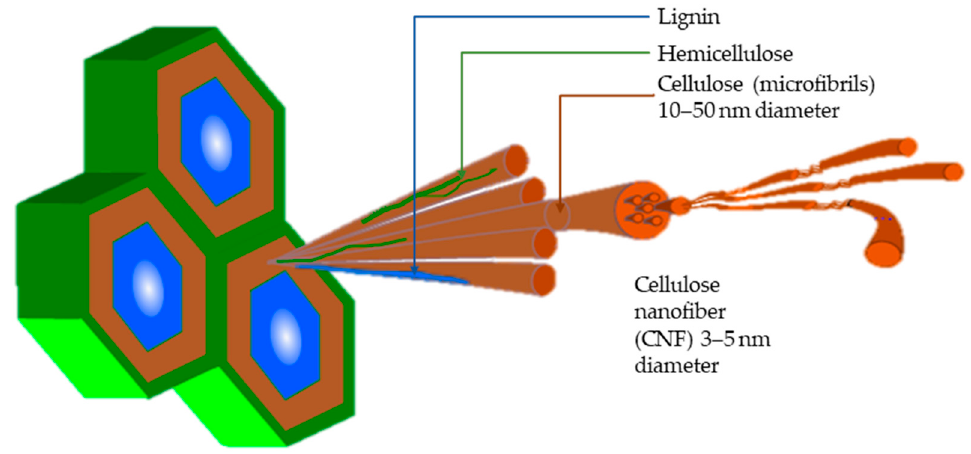
Figure 1. Hierarchical structure of cellulose fibres in LC cell wall.